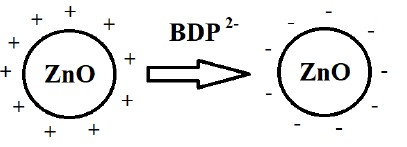
Figure 6. Schematic representation of the formation of negative charge.